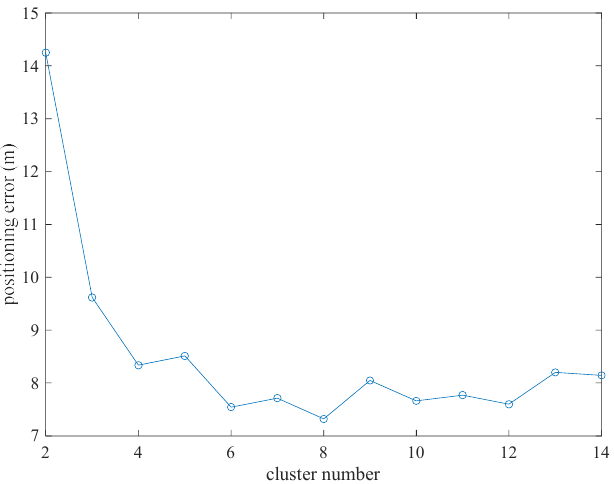
Figure 9. The positioning error changes with different cluster number.